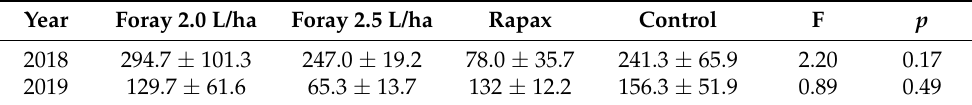
Table 2. Average (mean ± standard error) Lymantria dispar larval density occurred in 2018 and 2019 in untreated and Btk treated plots before insecticide applications. Analysis of Variance (ANOVA) statistics and p -value are reported.